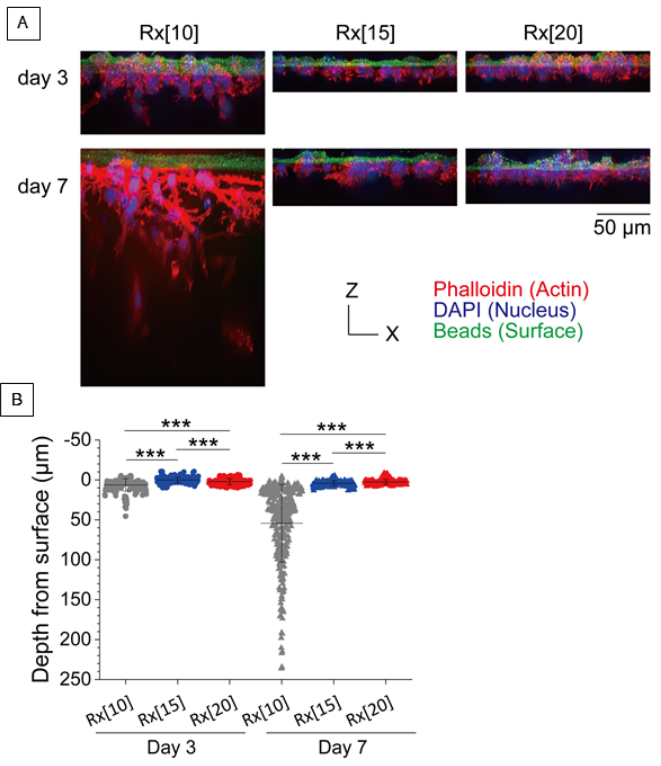
Figure 3. In vitro vertical migration assay for 3T3-Swiss cells into radiation-crosslinked hydrogels (RXgels): ( A ) Maxi mum intensity projection of confocal images of 3T3-Swiss cells on Rx[10], Rx[15], and Rx[20] grafts on day 3 (top) and day 7 (bottom). The cells were fixed and stained with TRITC-phalloidin for actin filaments (red) and DAPI for nuclei (blue). The surfaces of gels were stained with fluorescent microspheres (green); ( B ) Distribution of migrated cells in RXgels. The cells cultured on Rx[10], Rx[15], and Rx[20] for 3 days located at the depth of 6.23 ± 7.84 μ m ( n = 252 cells), 0.09 ± 3.43 μ m ( n = 251 cells), and 2.19 ± 3.84 μ m ( n = 216 cells), respectively. All values were significantly different (P < 0.05). The cells cultured on Rx[10], Rx[15], and Rx[20] for 7 days were located at a depth of 54.23 ± 48.65 μ m ( n = 294 cells), 4.13 ± 3.11 μ m ( n = 263 cells), and 2.48 ± 2.95 μ m ( n = 344 cells), respectively. All values were different (*** P < 0.0005). 3.2. In Vivo Evaluation of Gel Remaining Ratio and Granulation Tissue Ingrowth into RXgel The gel remaining ratio reflects the degradation speed of RXgel in vivo . We compared the results on days 10 and 14 with that on day 7 in each gel group. All the gels appeared to degrade over time. Rx[10] almost completely disappeared on day 7, while Rx[15] and Rx[20] showed similar degradation trends. There was no significant difference between days within the same sample group though (Figure 4).